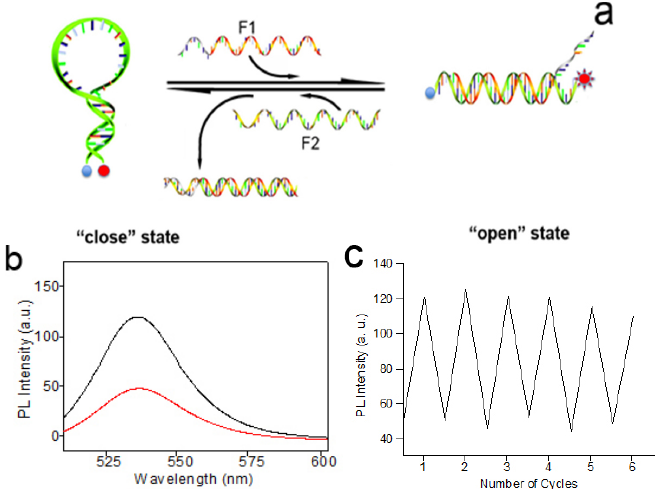
Figure 4. ( a ) Demonstration of the structural changes of the DNA nanomachine after the addition of F1 and F2. ( b ) Fluorescence spectroscopy after the addition of F1 (black curve) and F2 (red curve). ( c ) Fluorescence intensity showing the reversible switching of the DNA nanoswitch.